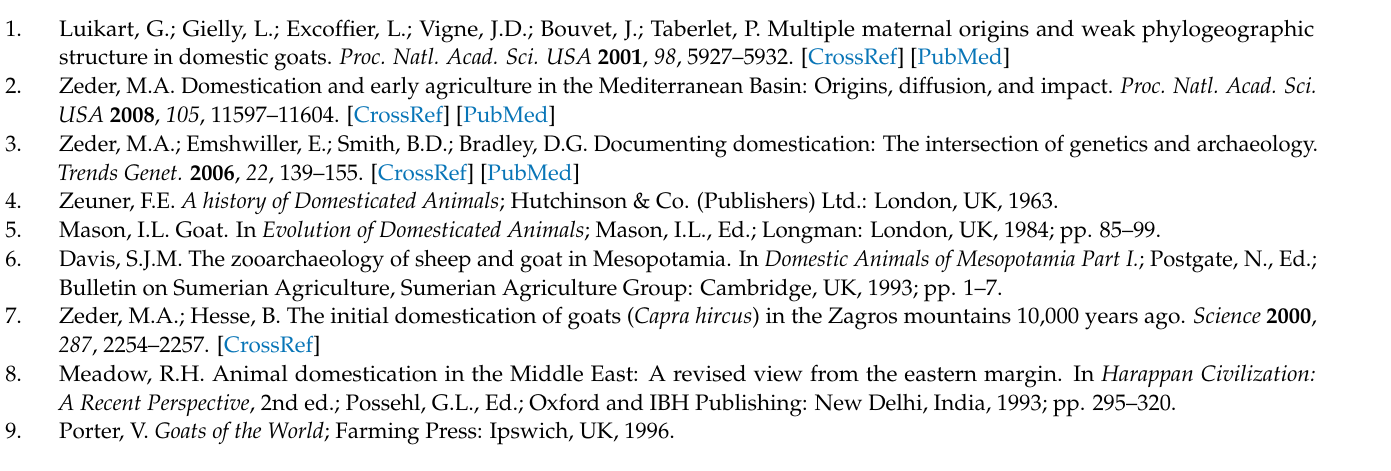
(a) Neighbor-Joining (NJ) phylogenetic tree, (b) Bayesian phylogenetic tree. Figure S3: Haplogroup A of Andaman goat and its relationship with A haplogroup goats of different regions (a) Neighbor- Joining (NJ) phylogenetic tree, (b) Bayesian phylogenetic tree. Figure S4: Haplogroup B of Andaman goat and its relationship with B haplogroup goats of different regions (a) Neighbor-Joining (NJ) phylogenetic tree. (b) Bayesian phylogenetic tree. Figure S5: Haplogroup D of Andaman goat and its relationship with D haplogroup goats of different regions (a) Neighbor-Joining (NJ) phylogenetic tree. (b) Bayesian phylogenetic tree. Table S1: Sampling details of Andaman goats. Table S2: Sequences used in the present study. Table S3: AMOVA analysis of haplogroup A goats of Andaman and other regions. Table S4: AMOVA analysis of haplogroup B goats of Andaman and other regions. Table S5: AMOVA analysis of haplogroup D goats of Andaman and other regions. Table S6: Haplotype diversity of goat